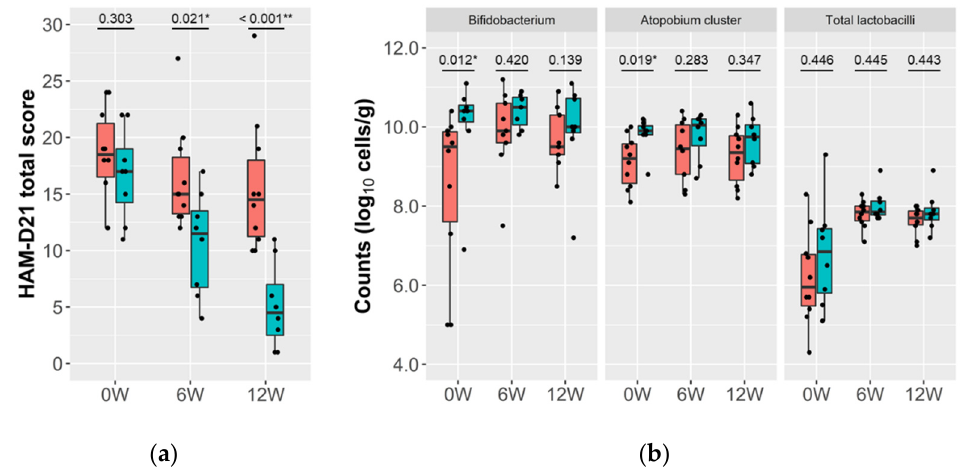
Figure 2. Responder analysis based on the change in HAM-D21 total score. The responder subgroups were designated based on the percent change in the HAM-D21 total score over the 12-week intervention period. Subjects whose percent change was − 50.0% or less were designated as “responder” ( n = 8; blue bars), with the remaining participants designated as “non-responder” ( n = 10; red bars) ( a ). Changes in the counts of Bifidobacterium, the Atopobium cluster, and total lactobacilli, are shown for the two groups ( b ). Wilcoxon’s rank sum test was used to compare the data between the two groups (* p < 0.050, ** p < 0.010), and the p -value is shown for each pair.